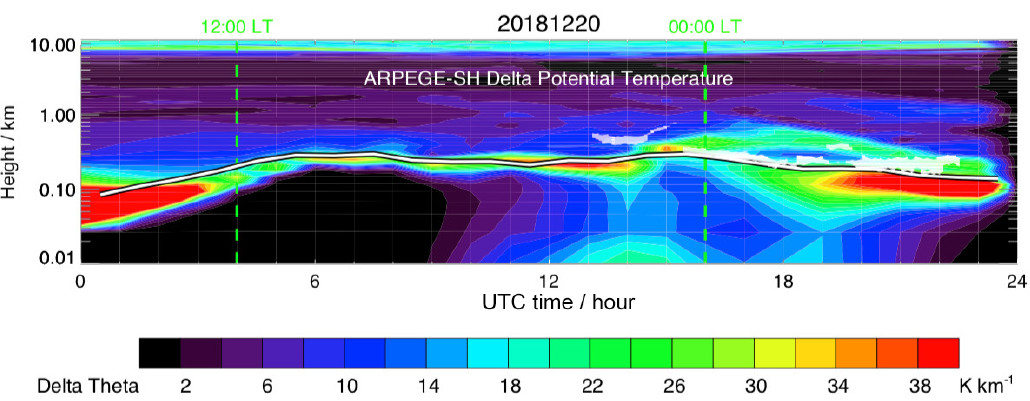
Figure 13. Same as Fig. 7 but for 20 December